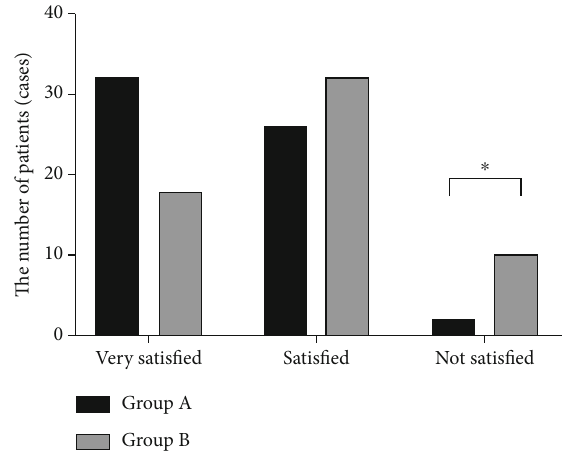
Figure 3: Comparison of nursing satisfaction in patients.